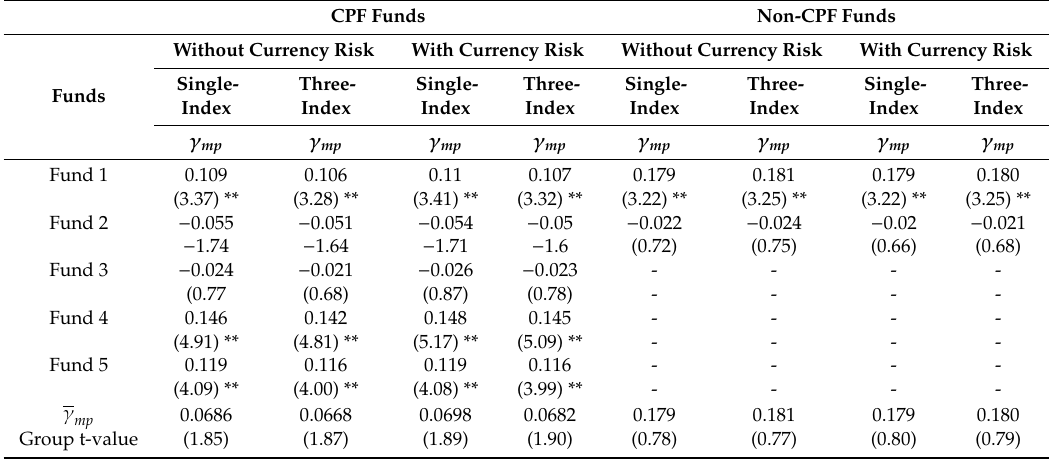
Table 8. Volatility-timing coe ffi cients for Greater China equity funds under CPF Investment Scheme and non-CPF